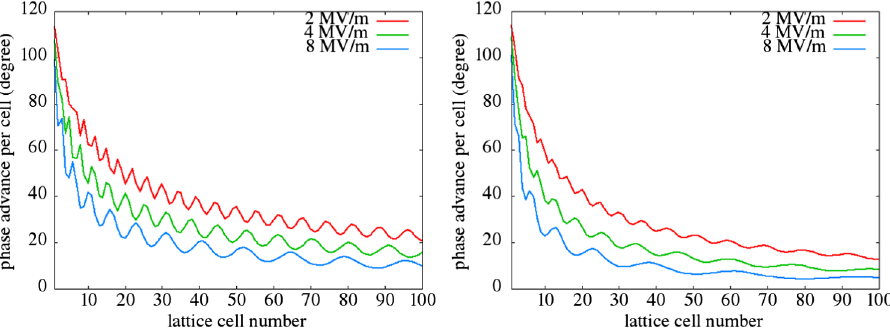
FIG. 13. The zero current horizontal (left) and longitudinal (right) phase advances as a function of lattice cell number in the quadrupole-rf channel.